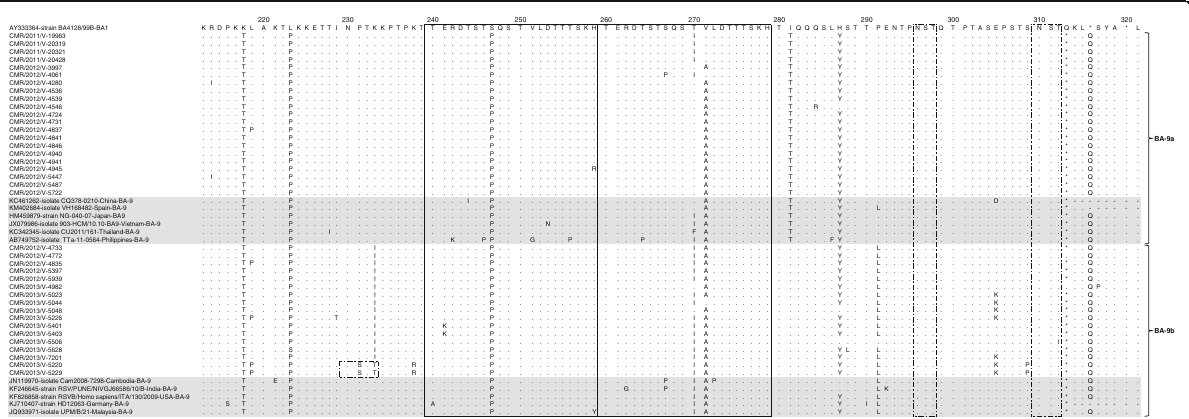
Fig. 4 Alignment of deduced amino acid of the second hypervariable region of the G gene from the sequences of HRSV-B. The alignments are presented in reference to BA4128/99B prototype strain (AY333364, positions 213 – 321). Potential N -glycosylation sites (NXT/S, where X is not proline) are shown by light dashed rectangles. Identical residues are represented by dots and stop codons by asterisks. The lack of amino acid is represented by dashes. The two copies of the duplicated region of 20 amino acids specific for BA genotype are represented by simple rectangles. Genotypes/subgroups are shown on the right. The light gray shading delineates the borders of Cameroonian sequences. Reference sequences are identified from left to right by their GenBank accession number, the name of the strain, country, and genotype. Cameroonian sequences are named from left to right by CMR (Cameroon), year of detection, and lab